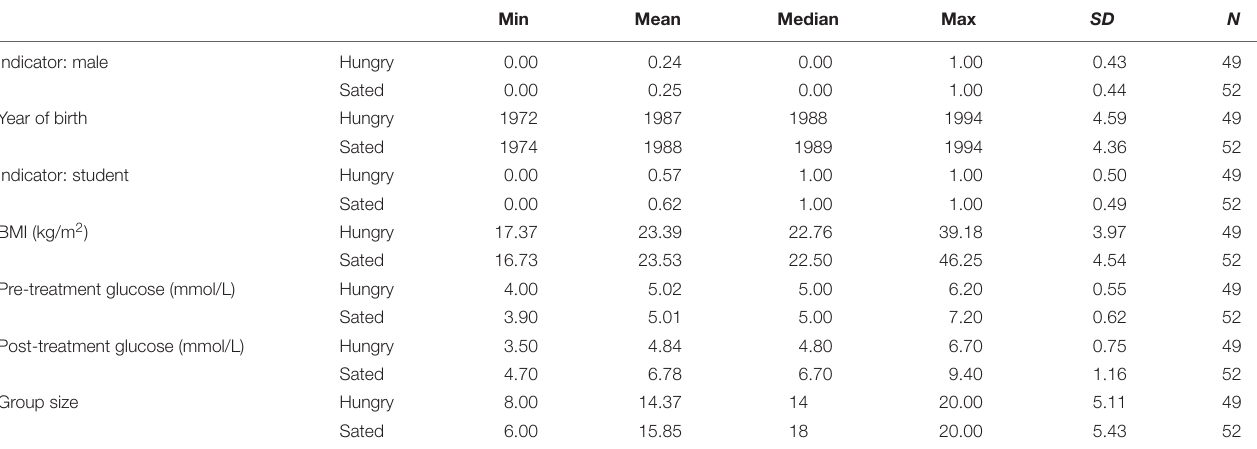
TABLE 1 | Descriptive statistics for treatment (sated) and control (hungry)